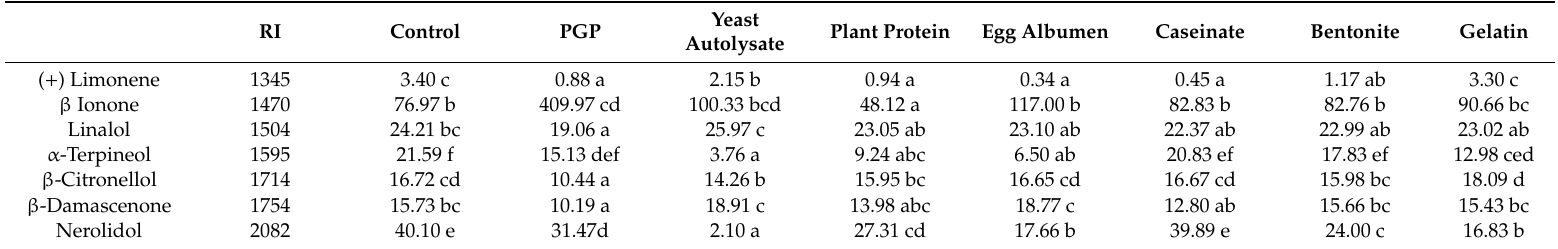
Table 3. E ff ect of the fining agents on terpenes and isoprenoid compounds ( µ g equivalents of 2-octanol /